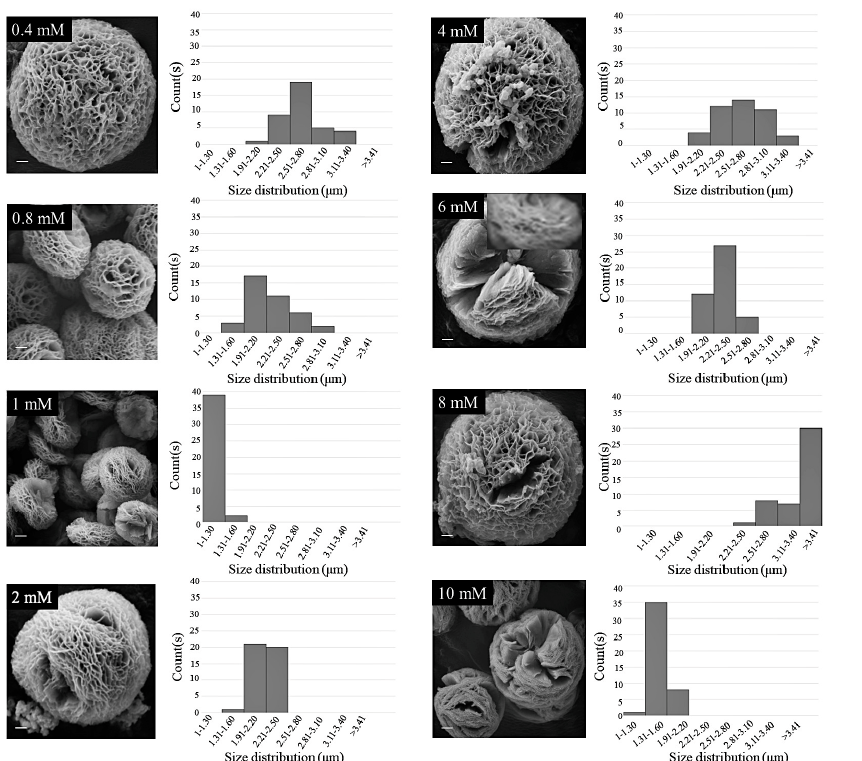
Figure 3. SEM images of Cu-SER MOFs exhibiting different morphologies at different Cu 2+ con- centrations. Scale bar = 100 nm (0.8 mM, 1 mM), 200 nm (2 mM, 4 mM, 6 mM, 8 mM), and 300 nm (0.4 mM, 10